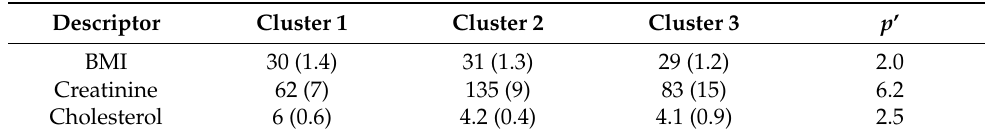
Table 5. Variables of the best k-means clustering for diabetic microangiopathy (DMA) underlying